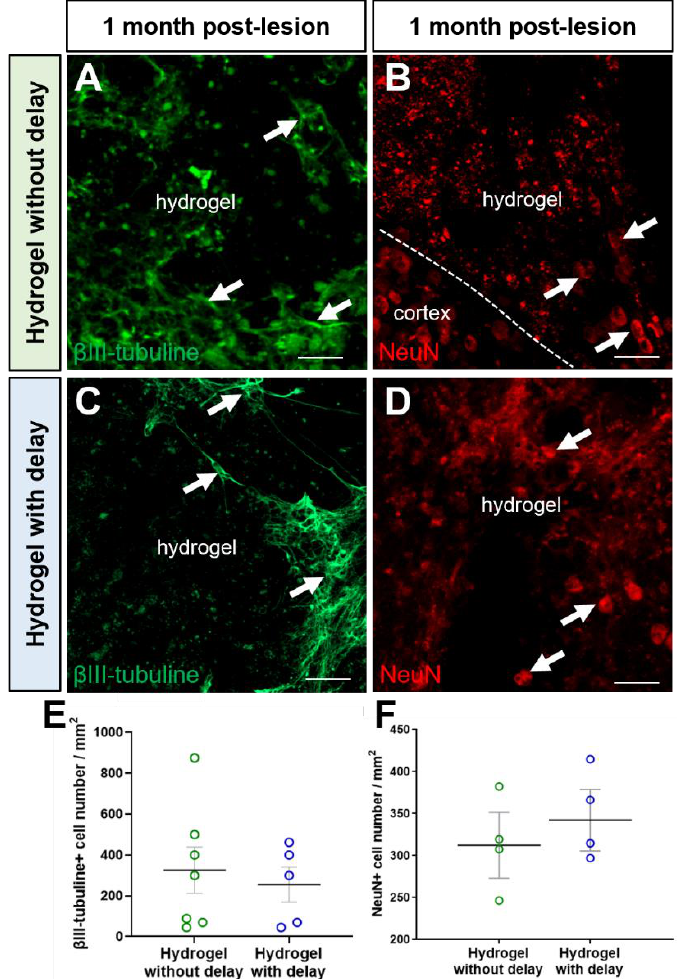
Figure 10. Neurons into hydrogel ( A – D ). Representative immunofluorescence staining of neurons labeled with β III-tubulin (green, arrows, ( A , C )) or with NeuN (red, arrows, ( B , D )) in no-delay ( A , B ) or delay hydrogel implanted groups ( C , D ). Scale bar: 20 μm. ( E , F ) Quantitative analysis of the number of βIII -tubulin neurons ( E ) or NeuN+ neurons ( F ) in no-delay (green) or delay (blue) hydrogel implanted groups. One-way ANOVA.